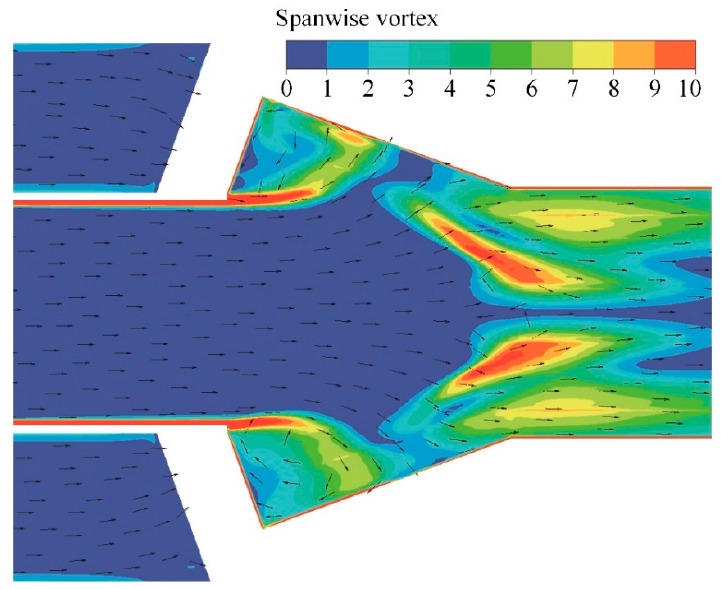
Figure 12. Spanwise vortex and velocity vector distribution in the XY plane.